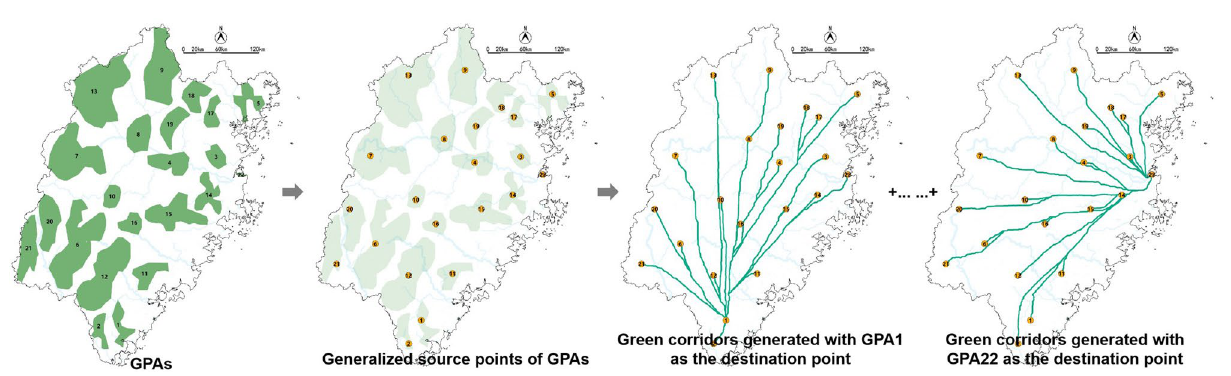
Figure 5. The generation process of green corridors in Fujian